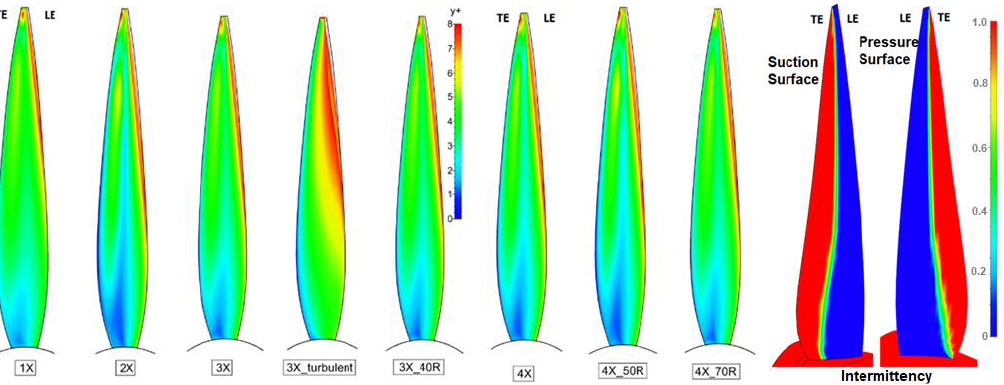
Figure 14. Suction side y + (0–8) for several domain sizes. Intermittency (0–1 in AGS model) on suction and pressure side is also shown. Table 2. Performance of various 3DCFD domain sizes are compared with py_BEM results.